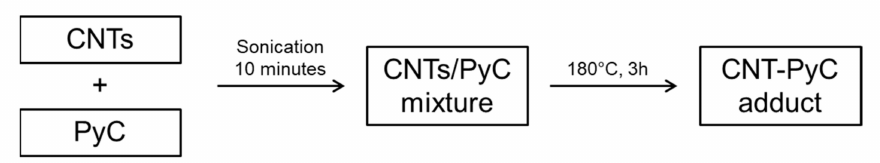
Figure 3. Block diagram for the preparation of carbon nanotubes (CNTs)-PyC adducts with the help of thermal